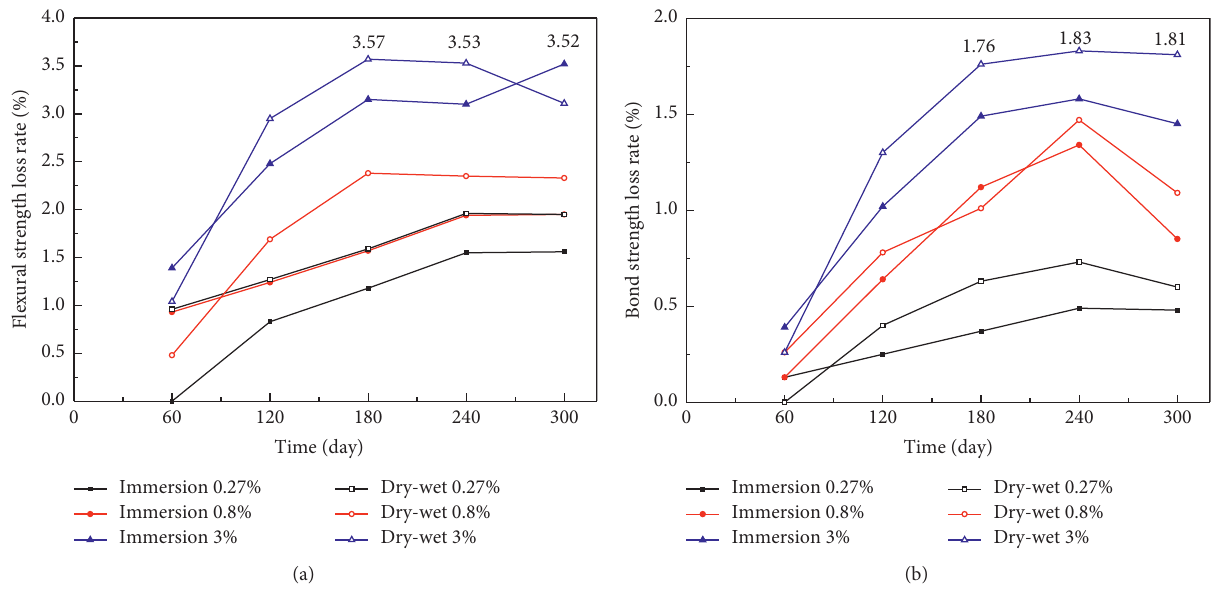
Figure 5: Loss rate of mechanical properties of reinforced concrete.